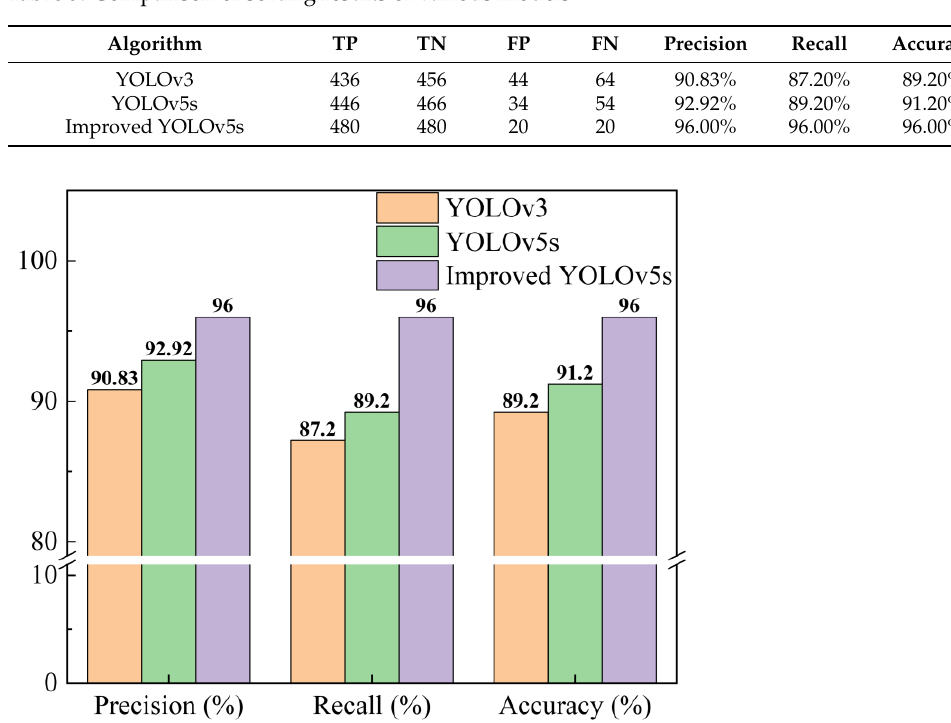
Table 5. Comparison of sorting results of various models.